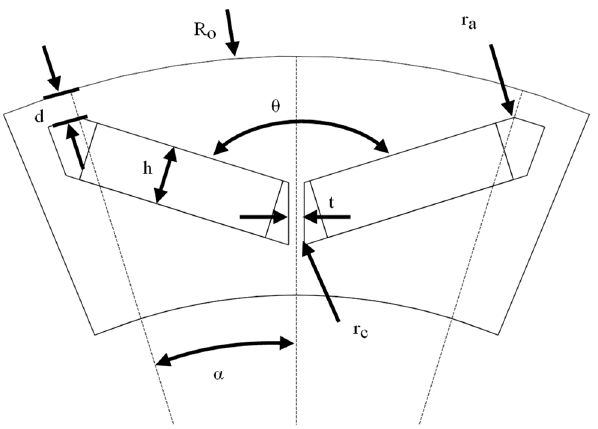
Figure 5. Parameter definition of a typical V-shaped rotor geometry (only the investigated parameters are shown).